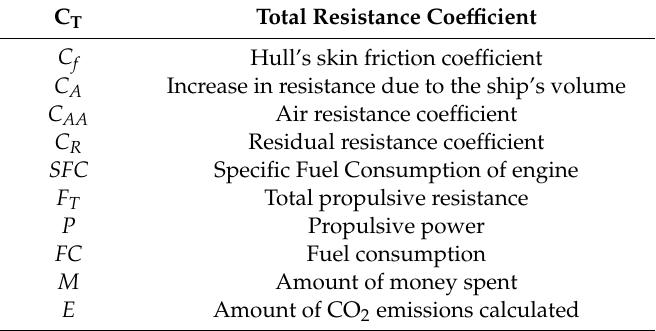
Table 1. Explanation of main abbreviations.